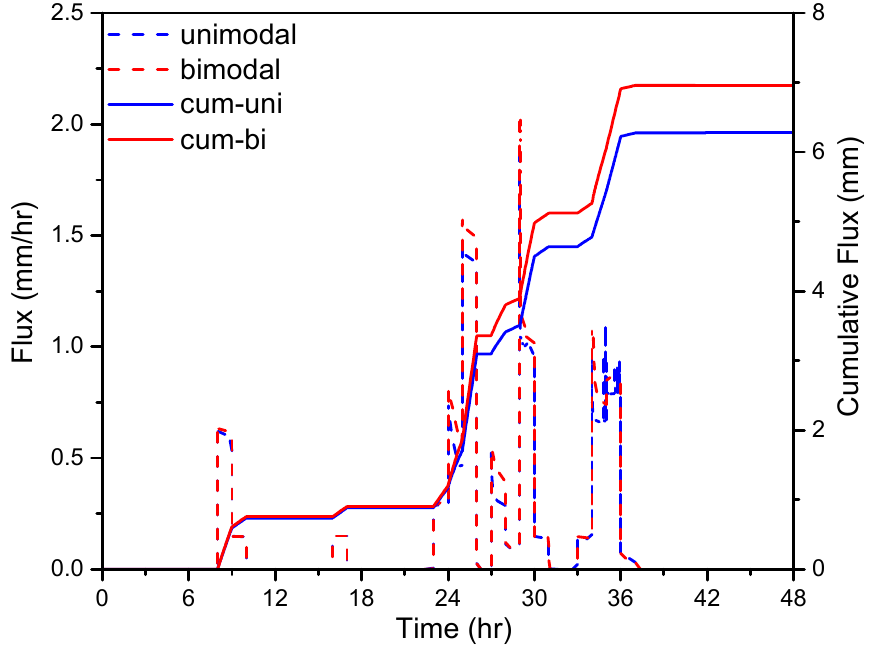
Figure 6. Rainfall infiltration and cumulative infiltration of unimodal and bimodal models.